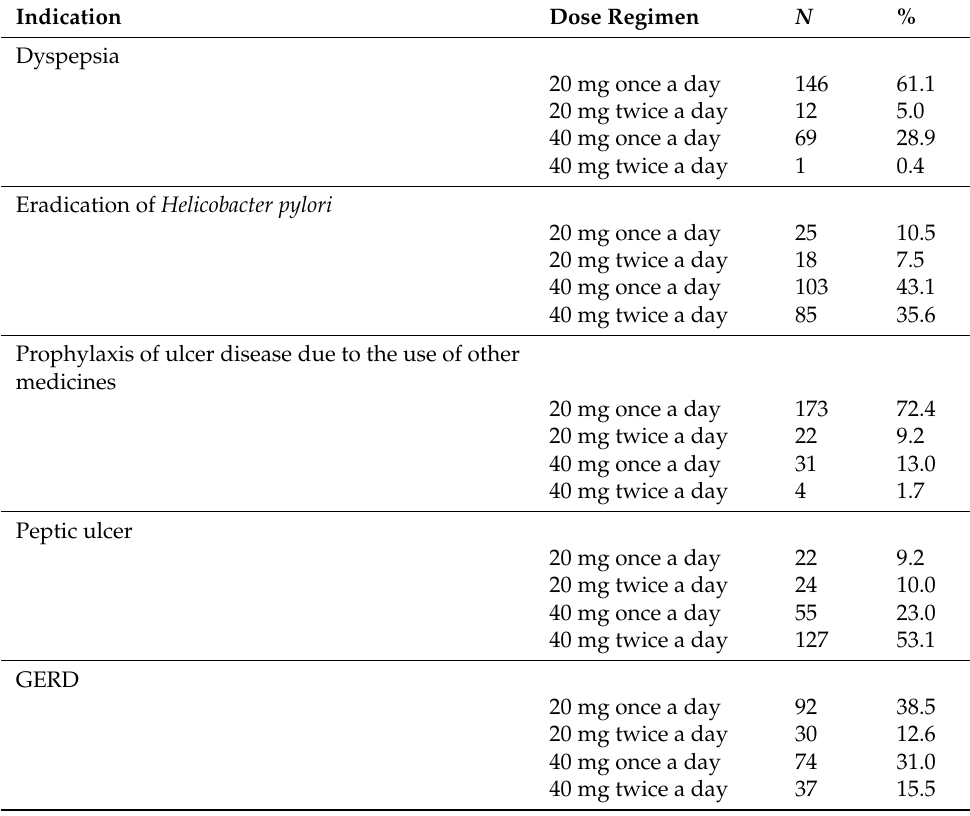
Table 4. Physicians’ prescribing habits of pantoprazole ( N =